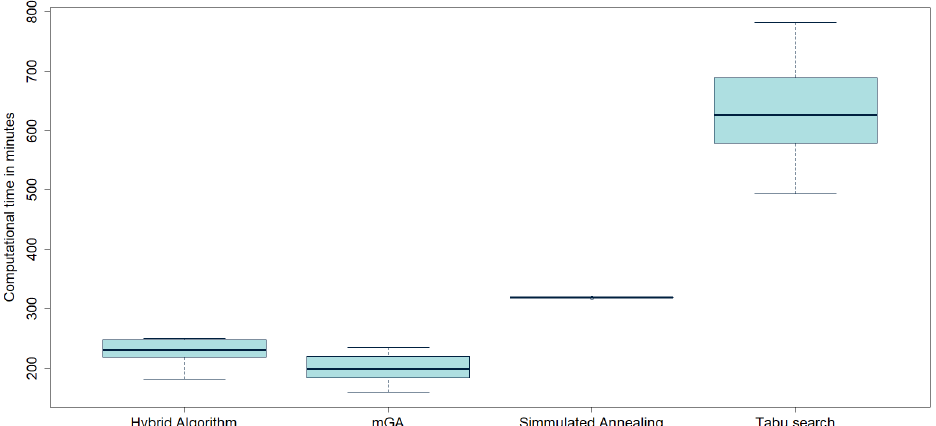
Figure 16. Box plot comparing the computation time for all four algorithms using a feasible solution as the initial